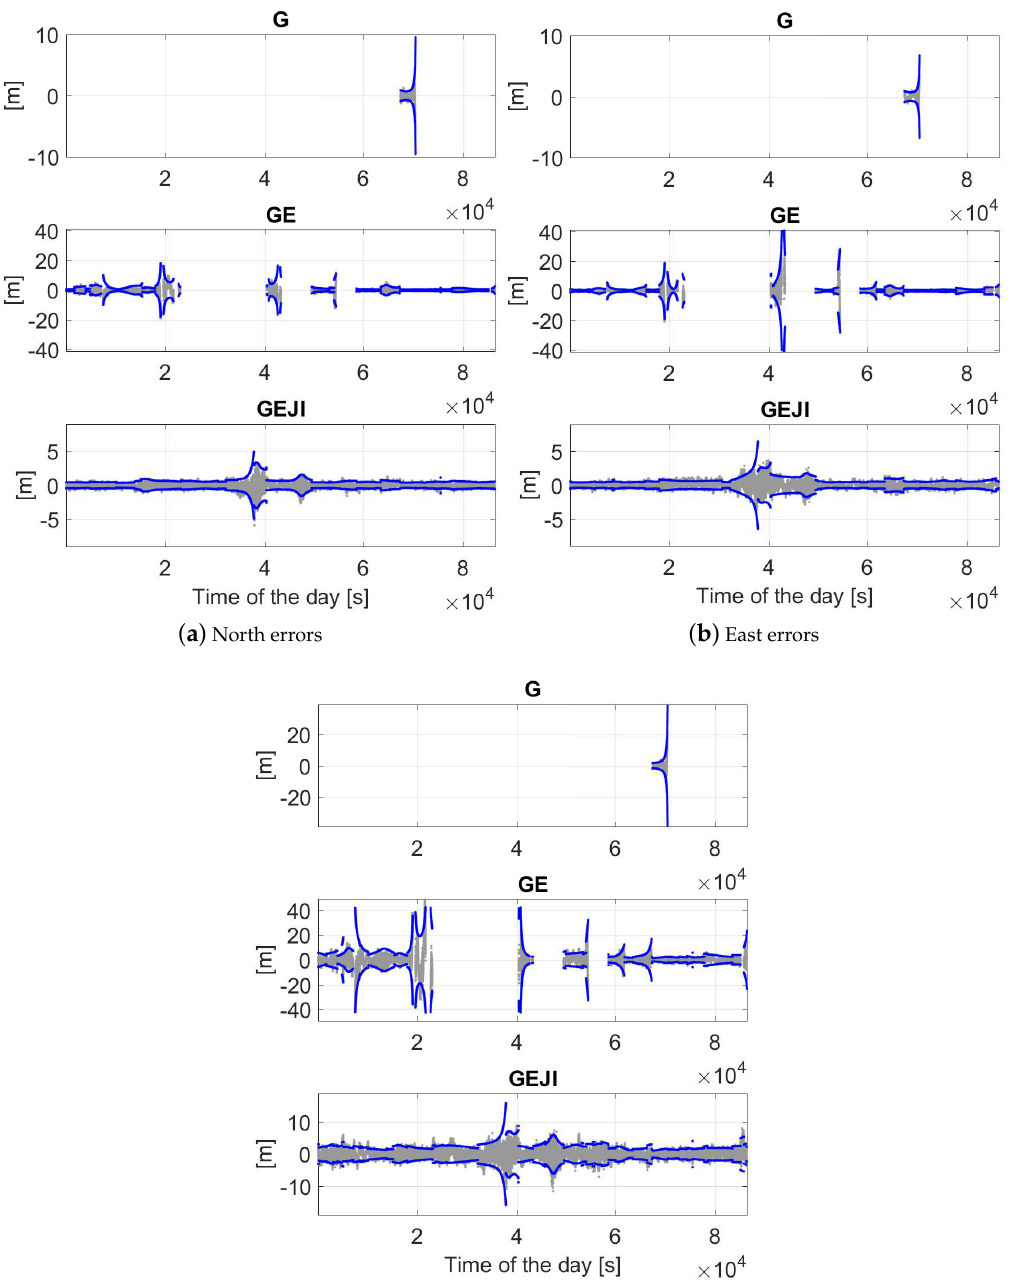
Figure 13. Ambiguity-float baseline errors in the north ( a ); east ( b ); and height ( c ) directions with the elevation mask of 40 degrees. Data for baseline CUAA-CUCC on DOY 224, 2018 was used. The gray and blue dots are the ambiguity-float solutions and their 95% formal confidence intervals, respectively. Note that the scales of the sub-figures are